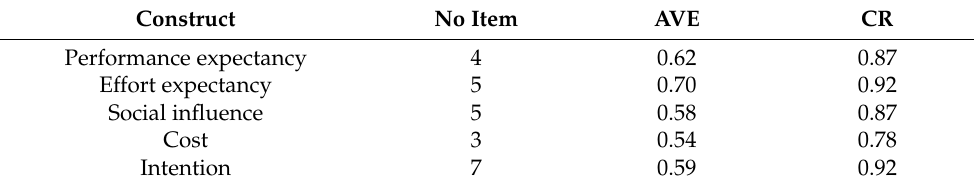
Table 2. Construct validity of study instruments.